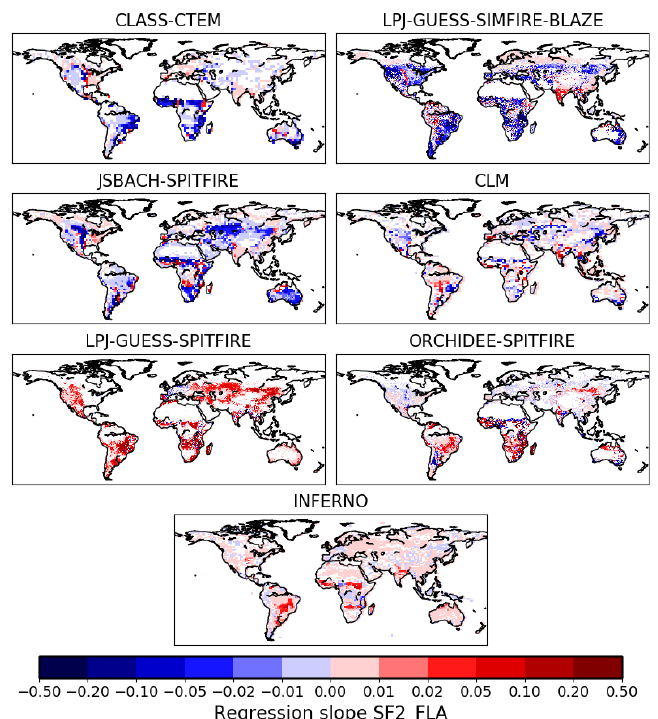
Figure A5. Spatial distribution of regression slopes for the difference between the baseline experiment SF1 and the sensitivity experiment